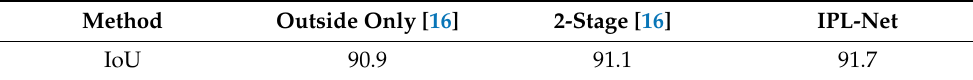
Figure 6. The results on PASCAL val set. The first three columns show the simulated inside-outside points with correspond- ing IOG result, the ground truth mask, and the image with the clicked outside points (blue dots). The right four columns show the initial inside point, the inside point of the first two steps, and the inside point of the final step with corresponding IOG result, respectively. Each segmentation result and the corresponding inside point are overlaid on the input image. Table 1. Comparison with outside points-based